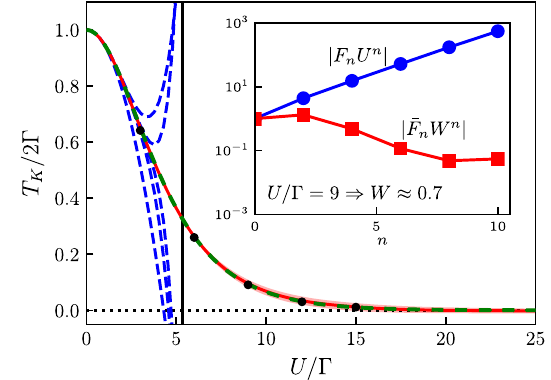
FIG. 3. Resummation of the Kondo temperature [as defined in 0 ). Plain red line: Eq. (15)] in the symmetric model ( ϵ d ¼ Resummation technique including Bayesian inference, using the Euler transform (error bar shown as a red shaded area); dashed thick green line: exact result from the Bethe ansatz [78]; black circles: reference NRG results; dashed blue lines: truncated series including up to N ¼ 2 , 4, 6, 8, and 10 terms. The vertical line shows the estimated convergence radius of the series. Inset: U n with n for U ¼ 9 Γ in the log-linear scale (blue Evolution of F n ¯ F W n obtained after conformal circles); evolution of the series n transformation (red squares). The value W ¼ 0 . 7 is obtained by ¯ F W n applying the conformal transformation to U ¼ 9 Γ . The n decreases exponentially, indicating a convergence of the trans- formed series while the original series (blue circles)